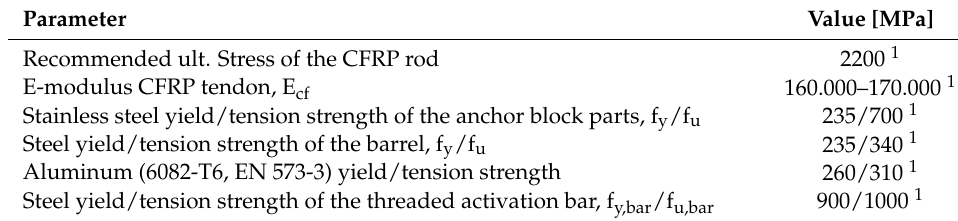
Table 1. Material properties of the anchor system.